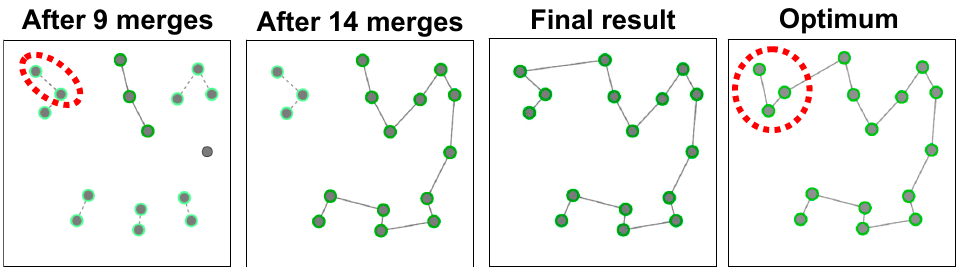
Figure 4. TSP-Kruskal [8] selected optimal choice for the first eight merges but the ninth merge ends up to sub-optimal result. Overall, only one sub-optimal choice is included, and in this case, it could be fixed by simple local search operations like 2-opt or link swap [9].